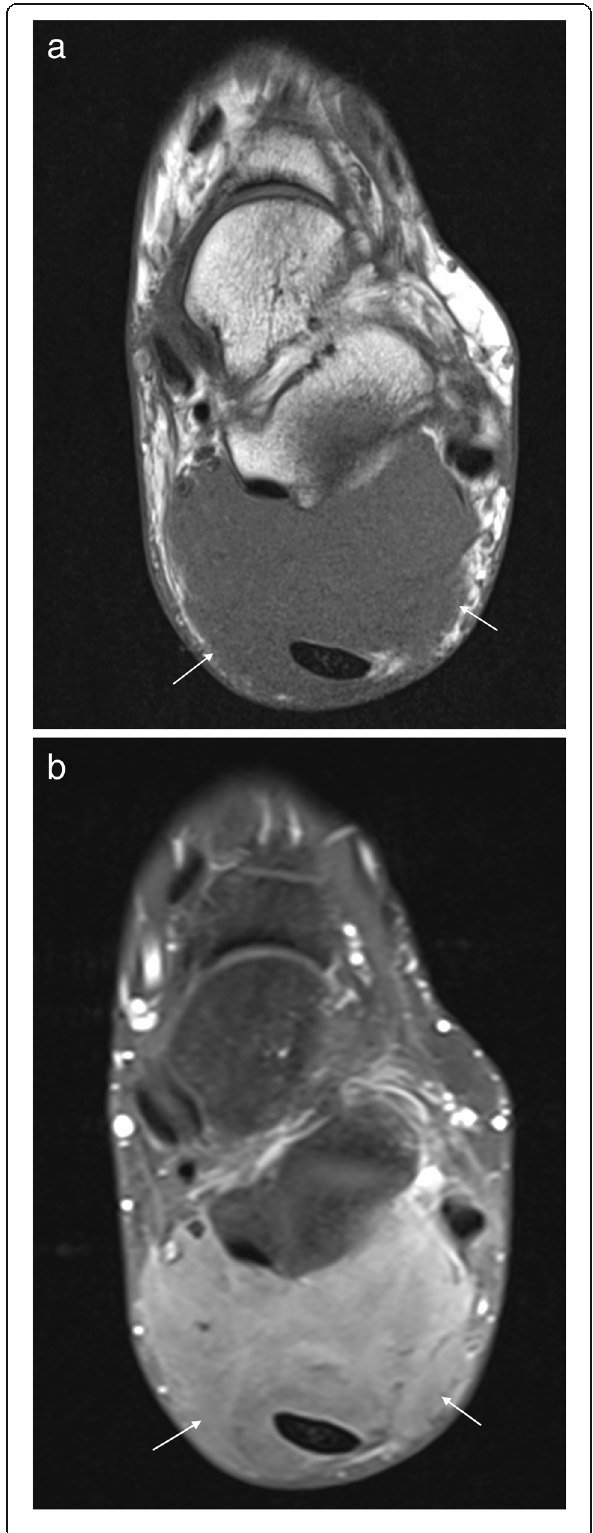
Fig. 15 Lymphoma. Axial T1FS ( a ) and post-contrast T1FS ( b ) images of the ankle demonstrating an infiltrative process surrounding the posterior tendons and neurovascular structures, isointense to skeletal muscle on T1W with mild diffuse contrast